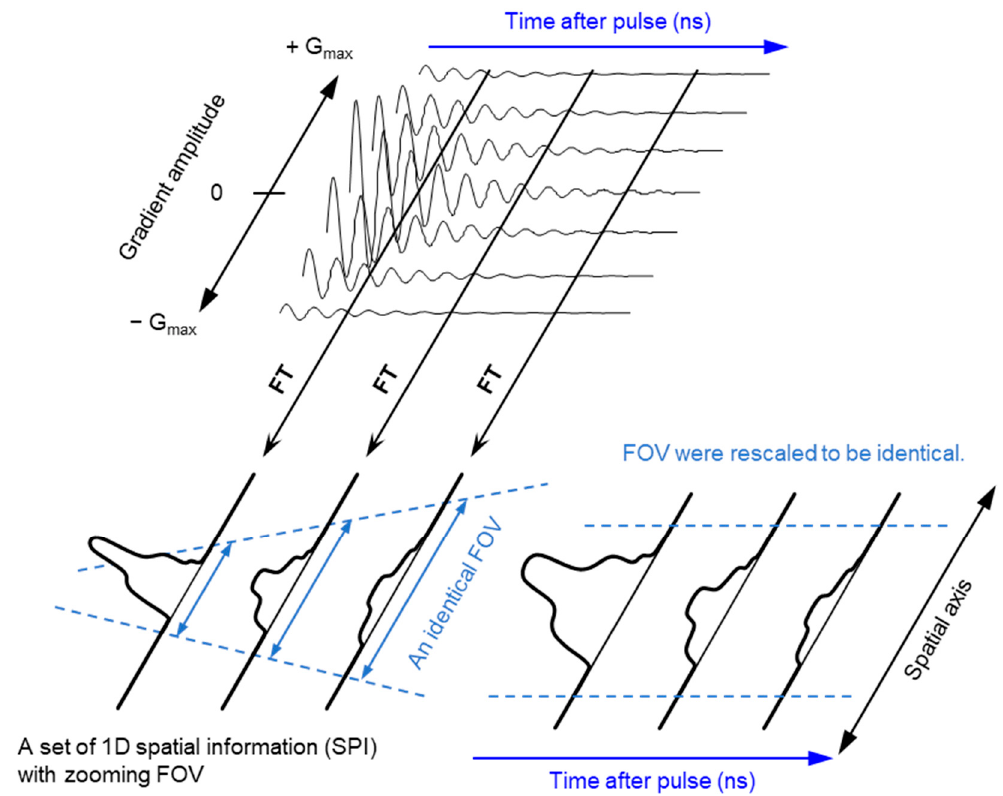
Figure 3. Principle of SPI and FT-CTSSI. ( Upper panel) FID data obtained under incremented but unidirectional field gradient. This is gradient-echo-like encoding of spatial distribution along with the direction of the field gradient. (Lower left panel) FT of gradient amplitude axis can give 1D spatial distribution, i.e., SPI. The FOV of observed SPI is zooming in depending on the time after pulse as per the equation, FOV = 2 π /( γ e · τ p · Δ G), where γ e is the gyromagnetic ratio of the electron, τ p is the time after pulse, and Δ G is the incremental step of the field gradient. (Lower right panel) The data in the identical FOV extracted and rescaled on a Cartesian matrix give a spectral-spatial image, i.e., 2D FT-CTSSI. FT along with the time axis can convert it to the spectra axis.